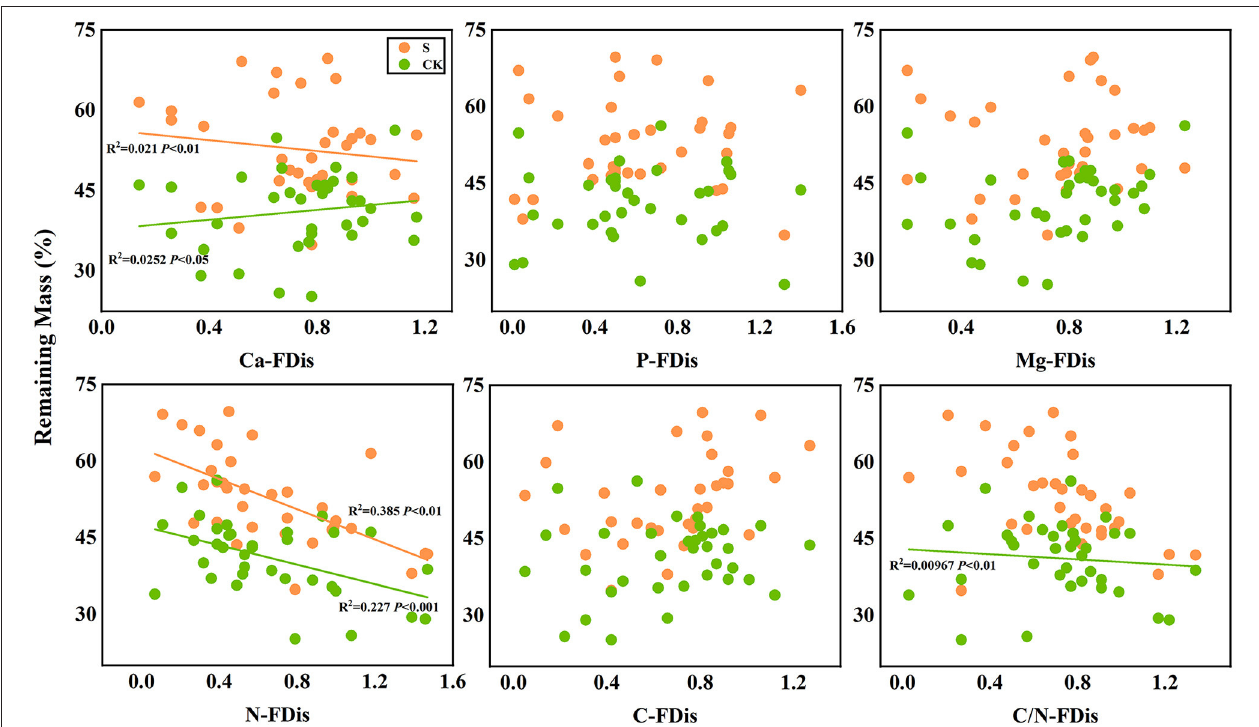
FIGURE 8 | Linear regression relationships between litter remaining mass rate and litter functional dispersion (FDis). S stands for litter that has been decomposed in the submergence environment, and CK stands for litter that has been decomposed in the terrestrial